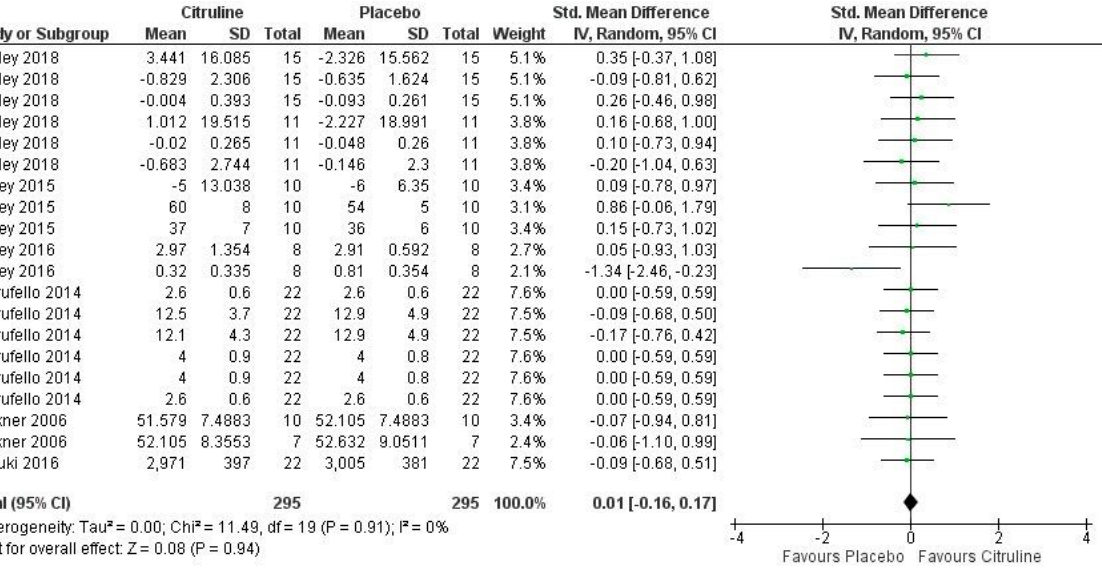
Figure 7. Forest plot comparative study of the effects of Cit supplementation on VO 2 kinetics [43,45,48,49,56,57].